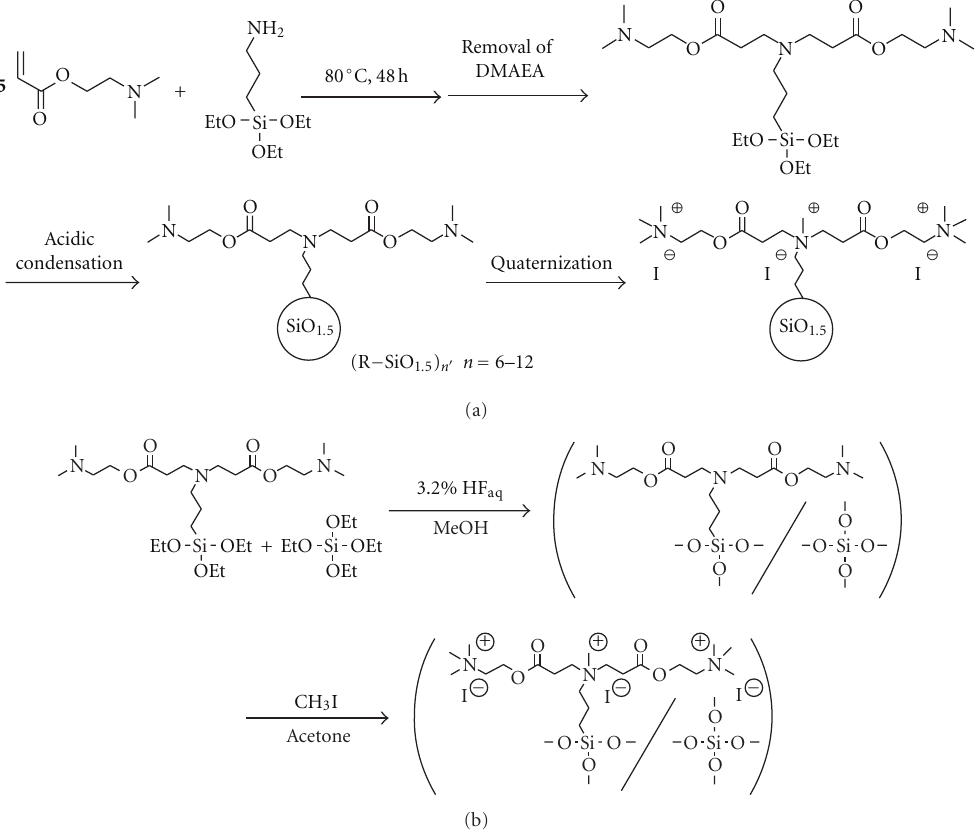
Figure 7: Synthetic routes for cationic silsesquioxane hybrids by (a) hydrolytic condensation of a functionalized precursor derived from 2- (dimethylamino)ethyl acrylate (DMAEA), followed by quaternization, and (b) hydrolytic cocondensation of tetraethoxysilane (TEOS) with the DMAEA-based triethoxysilane